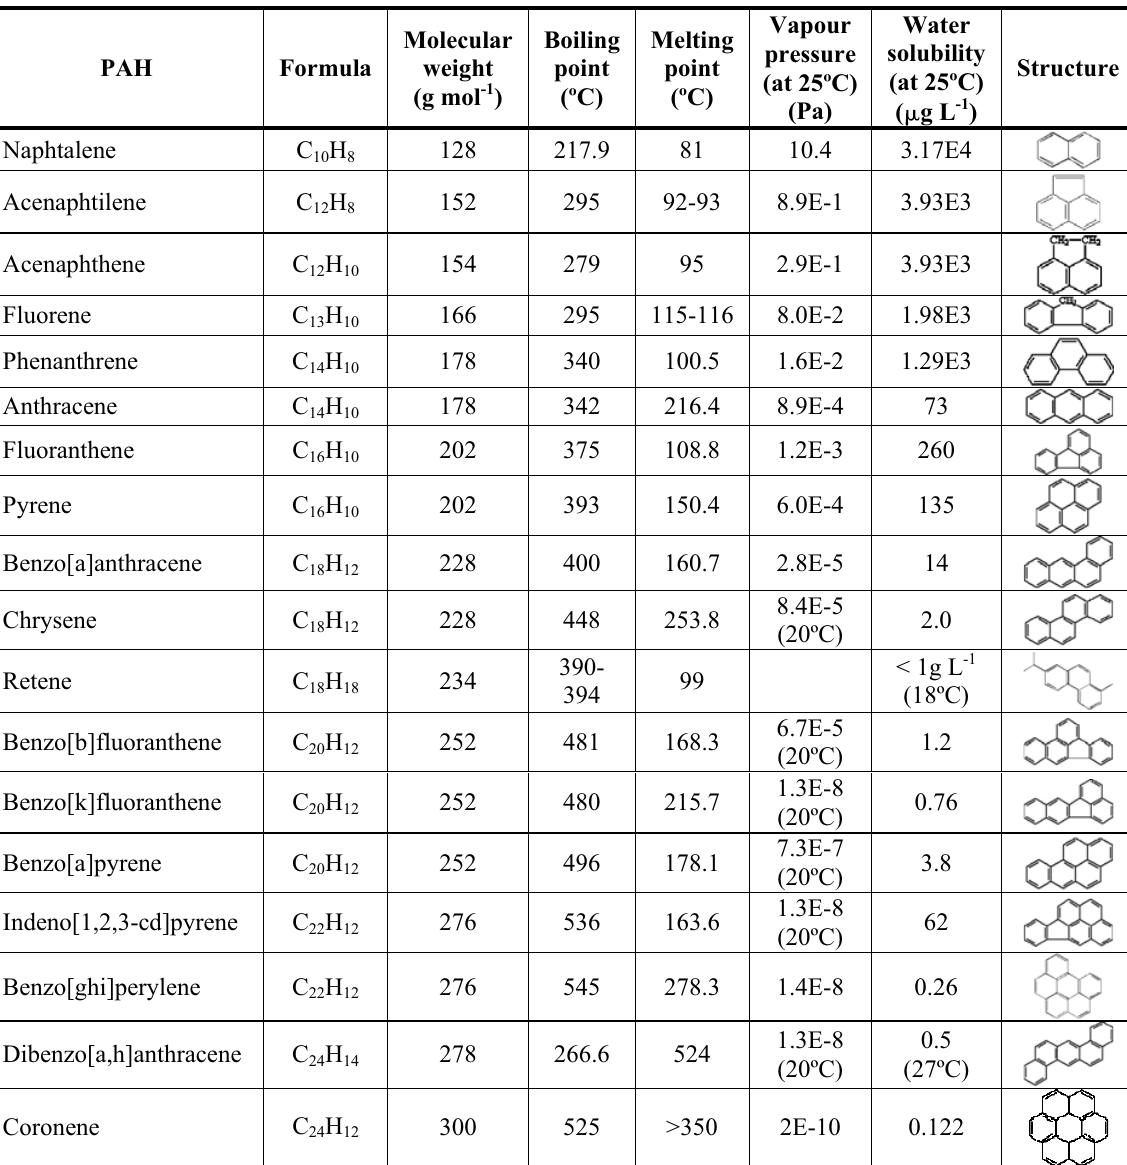
Properties and structures of select PAH (Sources: http://chemfinder.cambridgesoft.com/;